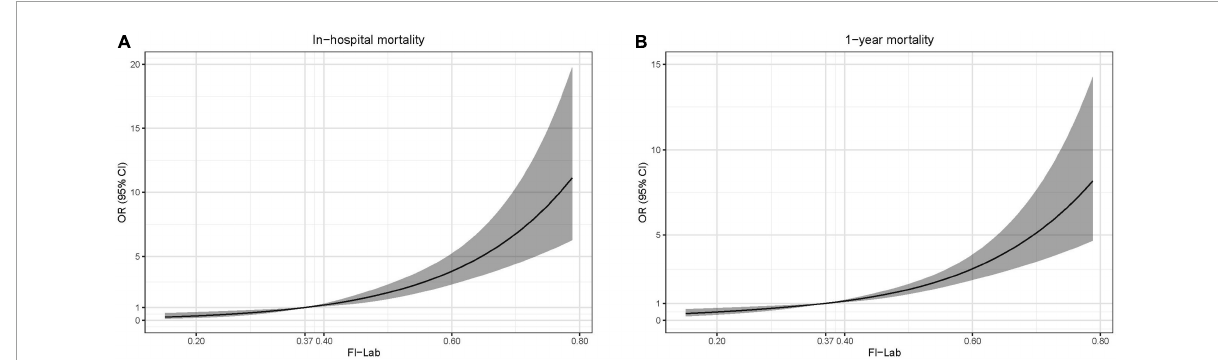
FIGURE1 Spline curves showing the association of the frailty index based on laboratory tests (FI-Lab) as a continuous variable with in-hospital mortality (A) and 1-year mortality (B) the dotted line (0.37) indicates the 25% quantile of the FI-Lab distribution. Spline curves were adjusted for age, gender, ethnicity, acute myocardial infarction (AMI) type, and sequential organ failure assessment (SOFA) score.